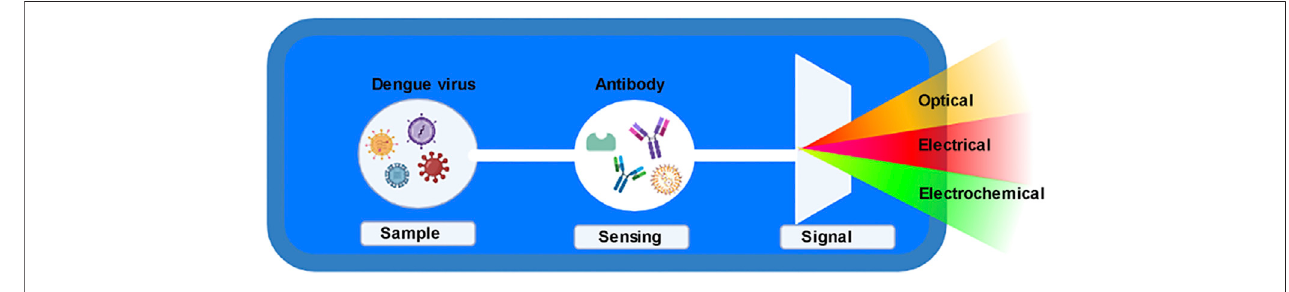
FIGURE 5 | Dengue virus